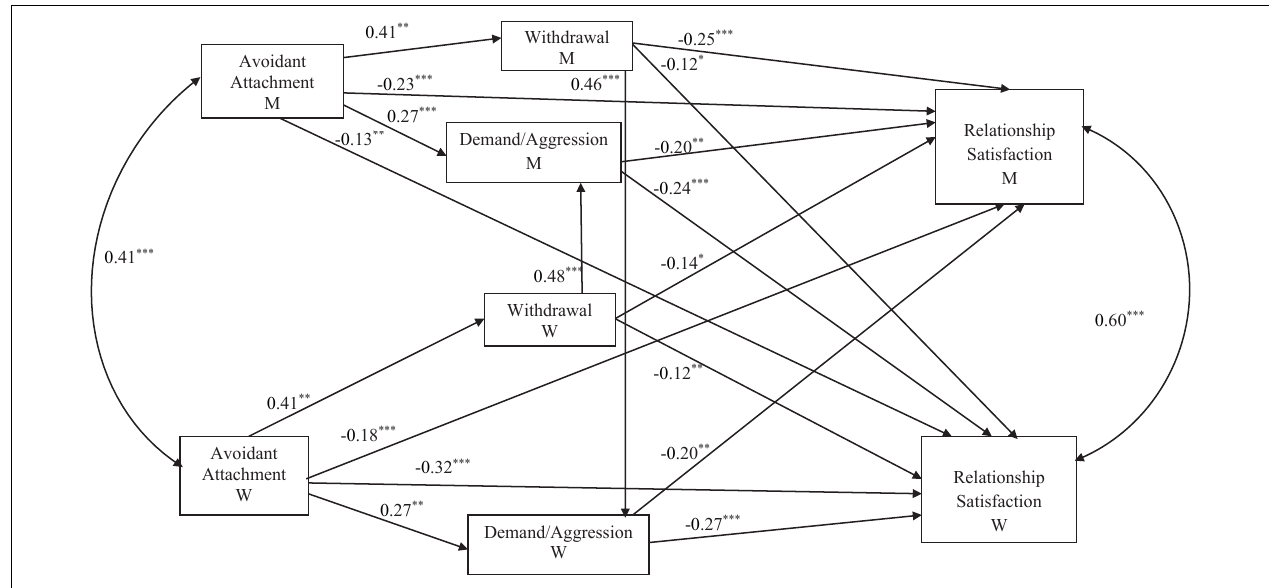
FIGURE 2 | Actor-partner model for avoidant attachment dimension, withdrawal-demand conflict resolution strategies, and relationship satisfaction. M = Men, W = Women. Beta values are unstandardized. ∗ p < 0.05; ∗∗ p < 0.01; ∗∗∗ p < 0.001.